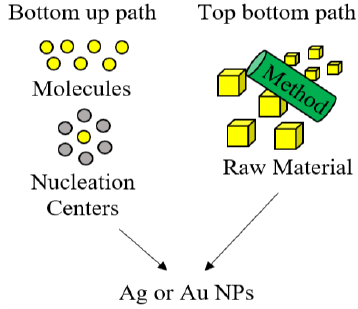
Figure 1. Synthesis of metal nanoparticles (NPs) from top-bottom and bottom-up paths [70].